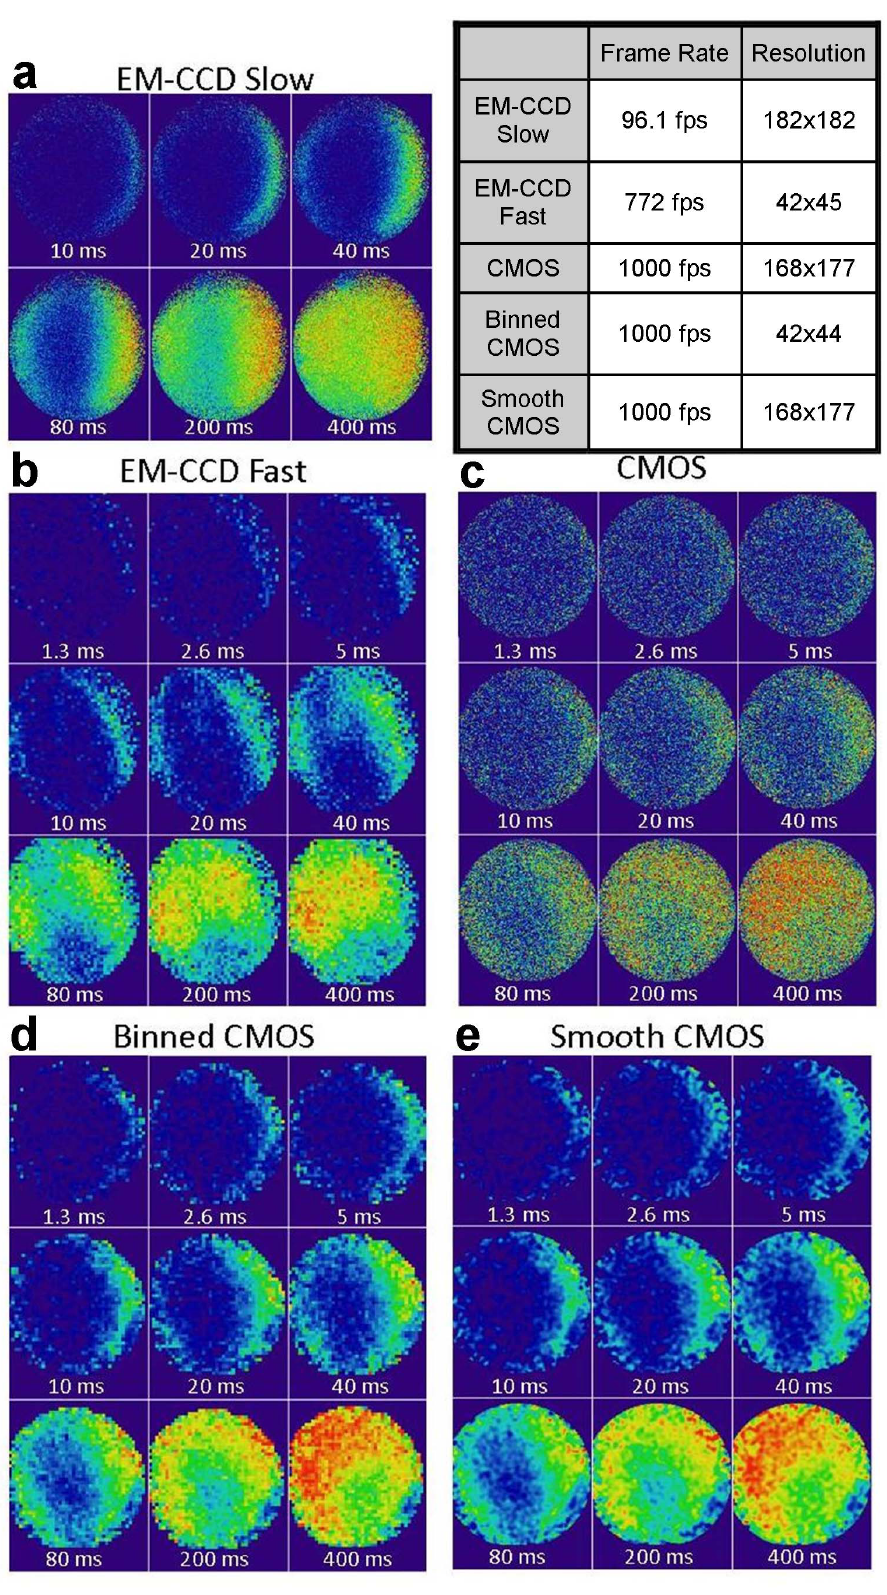
Figure 1. Temporal snapshots of the calcium influx into NG108 cells. Images are taken with each camera with different acquisition parameters.